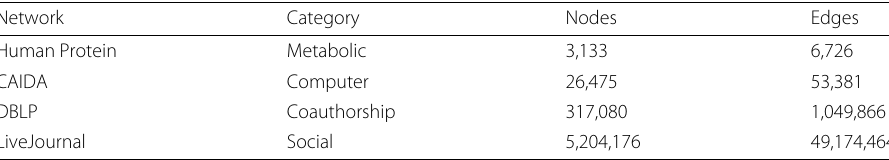
Table 1 Main features of the real network dataset Network Category Nodes Edges Human Protein Metabolic CAIDA